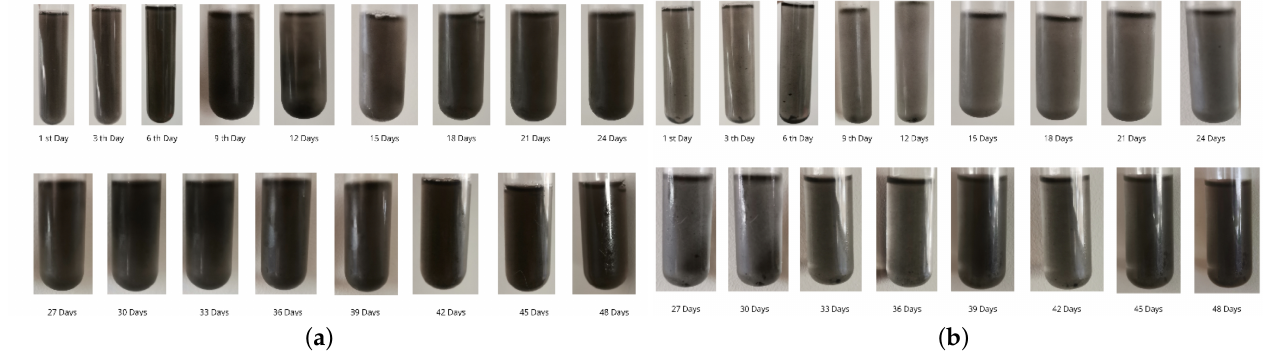
Figure 9. Stability of the nanofluids ( a ) MnO 2 AsA/rGO and ( b ) MnO 2